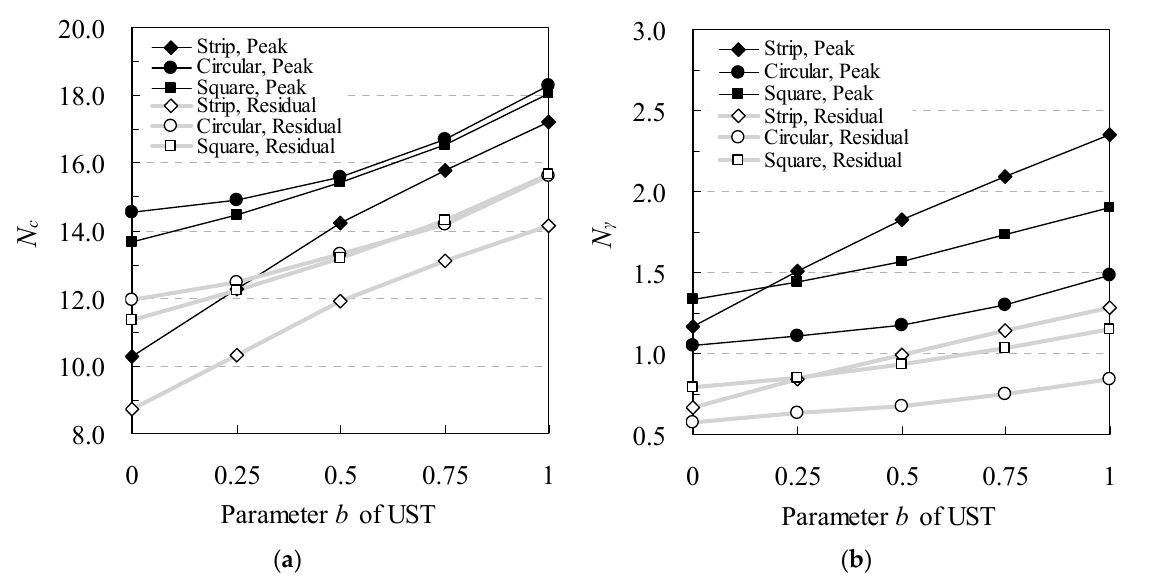
Figure 7. Peak and residual values of bearing capacity factor of strip, circular and square footings vary with UST parameter b : ( a ) N c , ( b ) N γ .